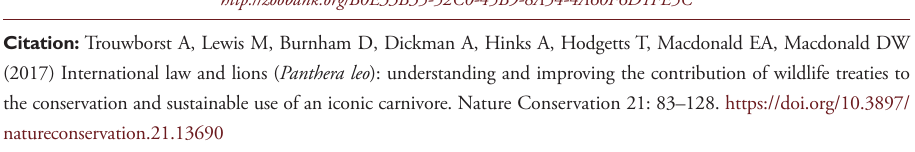
Lion, law, international wildlife law, Convention on Migratory Species (CMS), Convention on Interna- tional Trade in Endangered Species (CITES), Ramsar Wetlands Convention, World Heritage Conven- tion, Convention on Biological Diversity